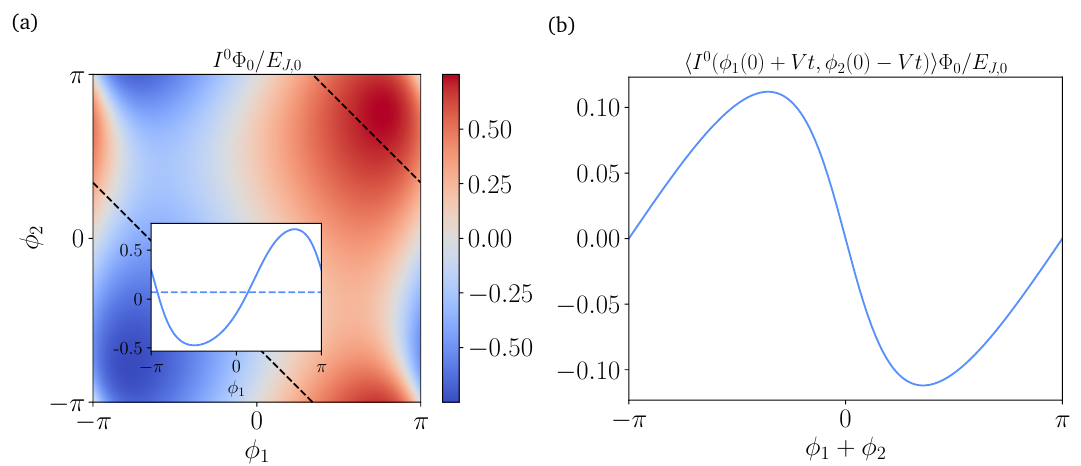
Figure 2: Currents across the E junction in the circuit of Fig. 1 with J ,0 = E / 2, E = E / 4, E = 0. (a) Instantaneous current at fixed φ E J ,1 J ,0 J ,2 J ,0 C The inset shows the current along the quartet line φ line). Since the average (blue dashed line) is finite there is a quartet DC super- current. (b) Average current along quartet trajectories with different phase